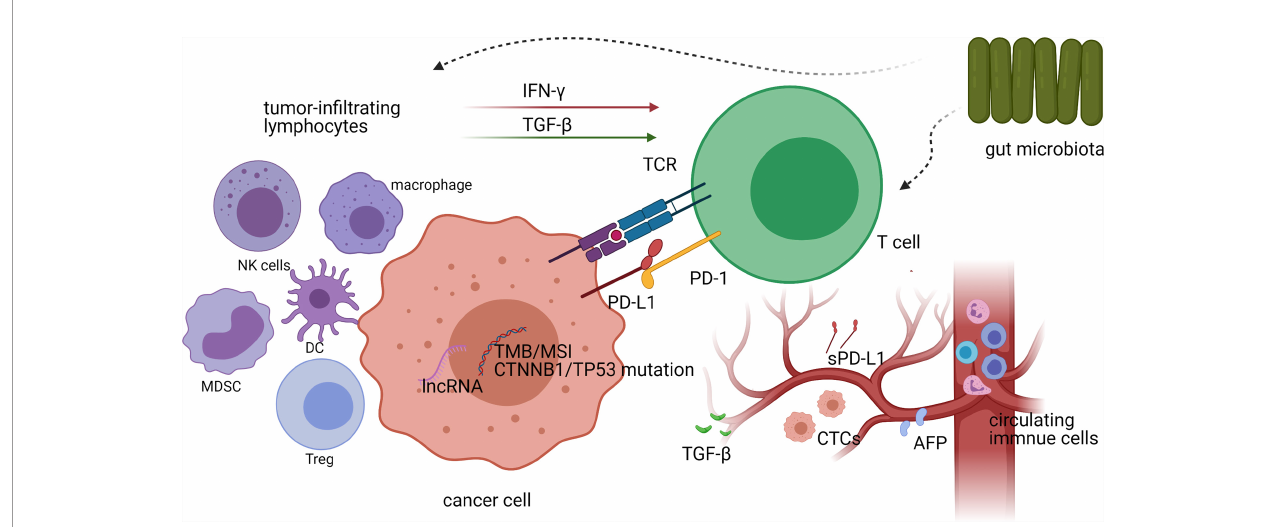
FIGURE 2 | A schematic representation of biomarkers for predicting treatment responses to immune checkpoint inhibitors (ICIs) in vivo and their interactions with each other. Both the genetic characteristics and the expression of PD-L1 in tumor cells, as well as the density and diversity of tumor-in fi ltrating CD8 + T cells, have the potential to predict the ef fi cacy of ICI treatment in hepatocellular carcinoma (HCC). Other tumor-in fi ltrating lymphocytes in the tumor microenvironment affect T- cell activity by secreting cytokines (such as IFN- g and TGF- b ), thereby affecting the ef fi cacy of ICI treatment. The gut microbiota also affects the responses to ICI treatment by in fl uencing the activity of tumor-in fi ltrating lymphocytes (TILs), while circulating biomarkers in peripheral blood can also be used as predictors of immunotherapeutic ef fi